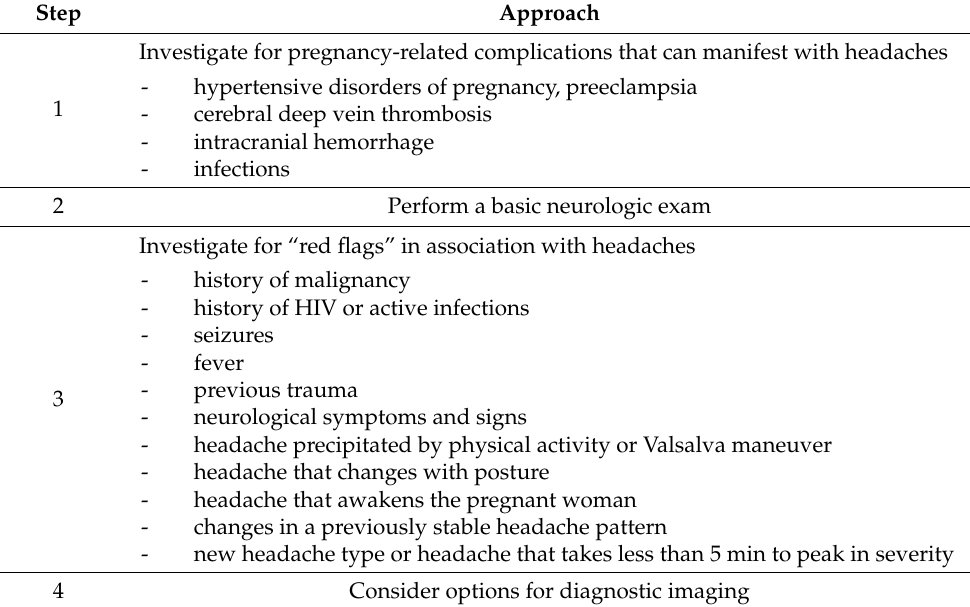
Table 1. Approach to investigating headaches in pregnant or postpartum